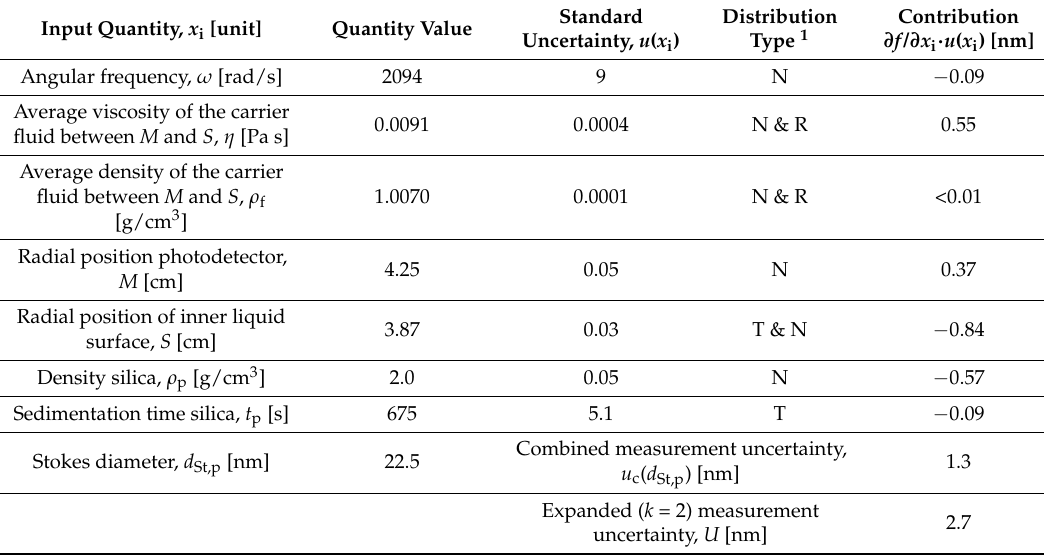
Table 5. Uncertainty budget for a single disc-CLS measurement (reference method) of nominally 20 nm silica nanoparticles (ERM-FD102).